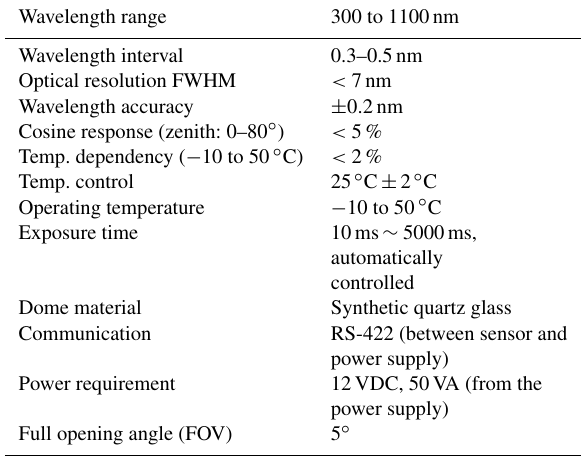
Table 1. Main specifications of the EKO MS-711 spectroradiome-